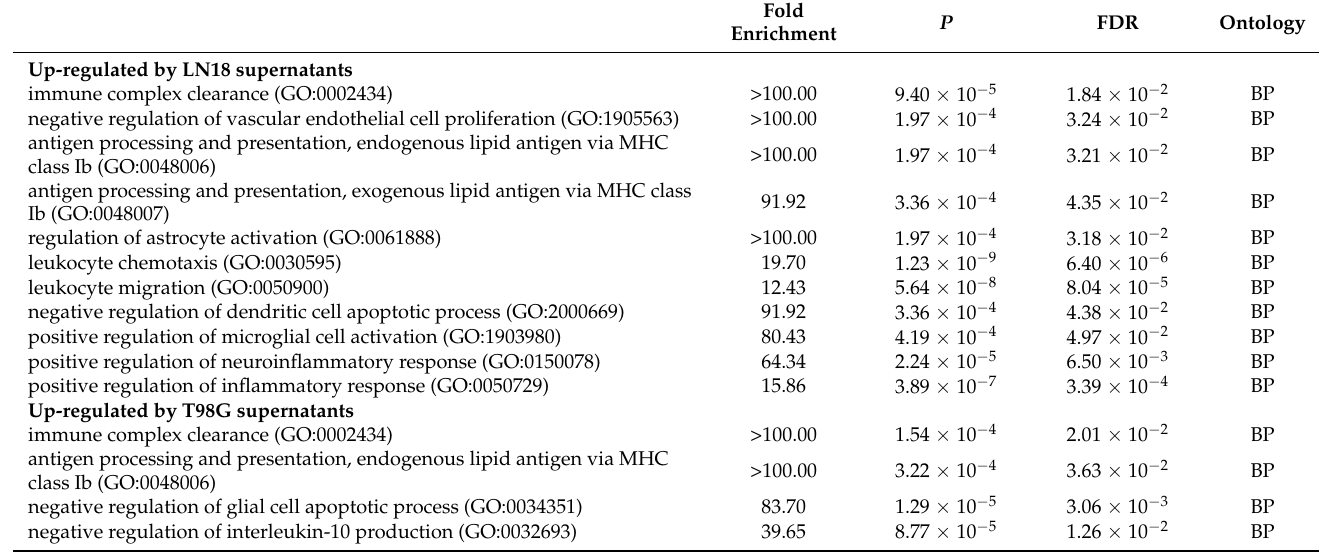
Table 2. Up-regulated GO enrichment analysis using the Panther database. Select enriched GO terms from up-regulated genes in THP-1 cells treated with LN-18 or T98G control supernatants. This is a subset of Biological Process (BP) terms from the full GO term list. GO terms are shown that had greater than 10-fold enrichment.